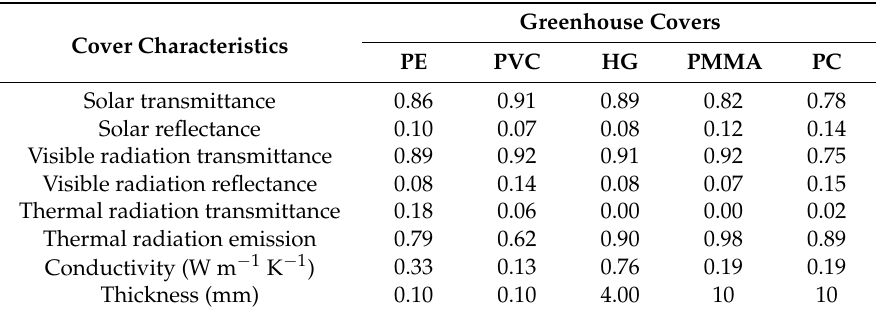
Table 3. Characteristics of the greenhouse cover